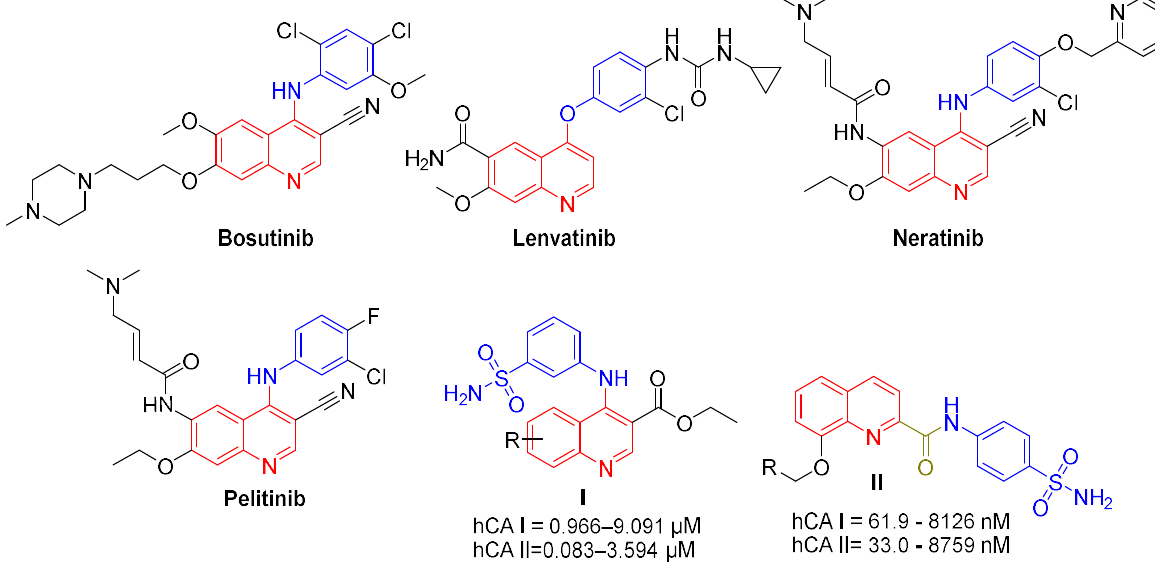
Figure 1. Chemical structure of clinically approved quinoline-based drugs; Bosutinib, Lenvatinib and Neratinib, and the investigational drug Pelitinib, as well as CAIs quinolines I and II